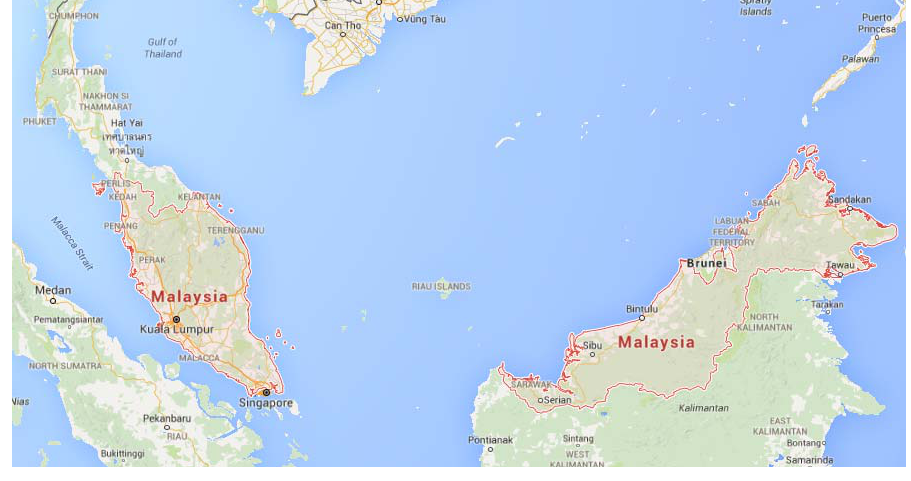
Figure 3. Malaysia Map from Google Maps.